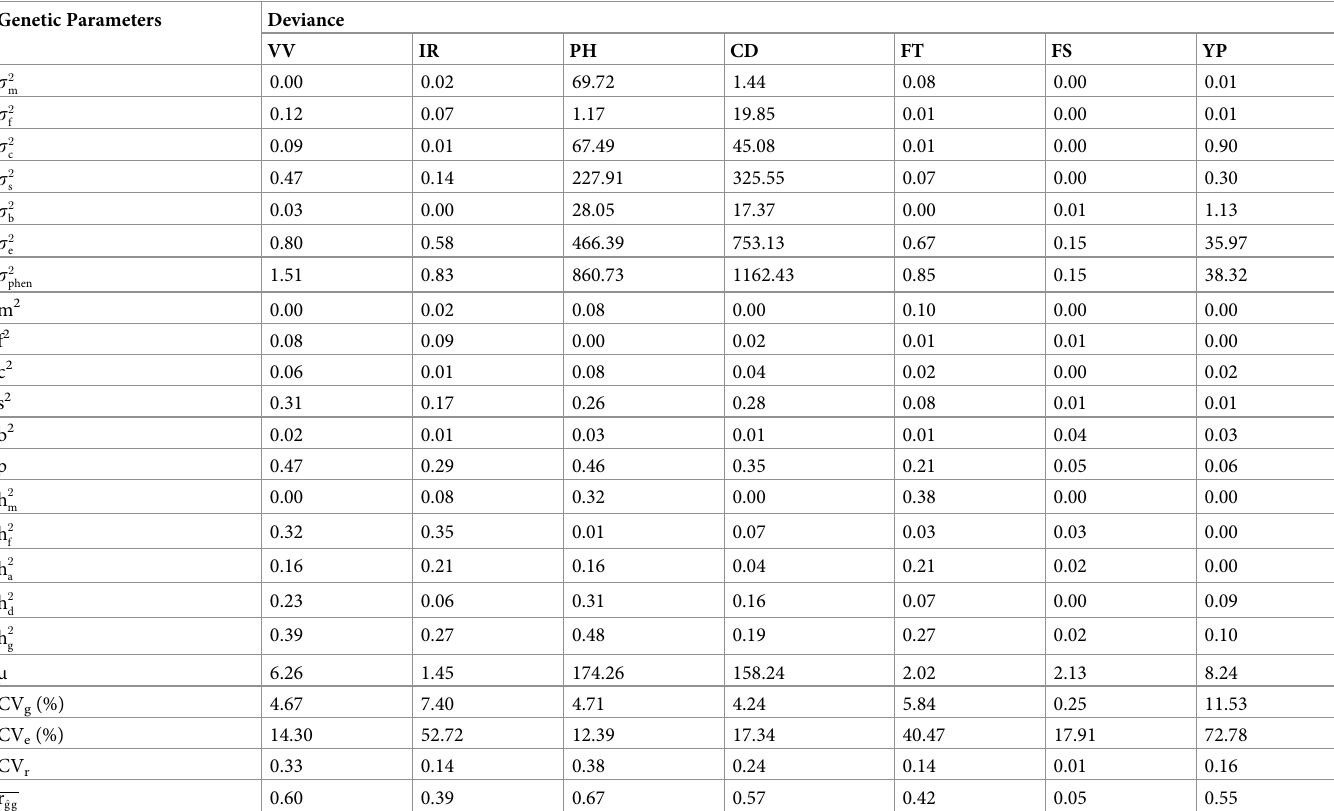
Table 8. Estimates of variance components and genetic and environmental parameters for the traits: Vegetative vigor (VV), incidence of rust (IR), plant height (PH), canopy diameter (CD), fruit ripening time (FT), fruit size (FS), and yield per plant (YP), evaluated in the hybrid coffee population. Genetic Parameters